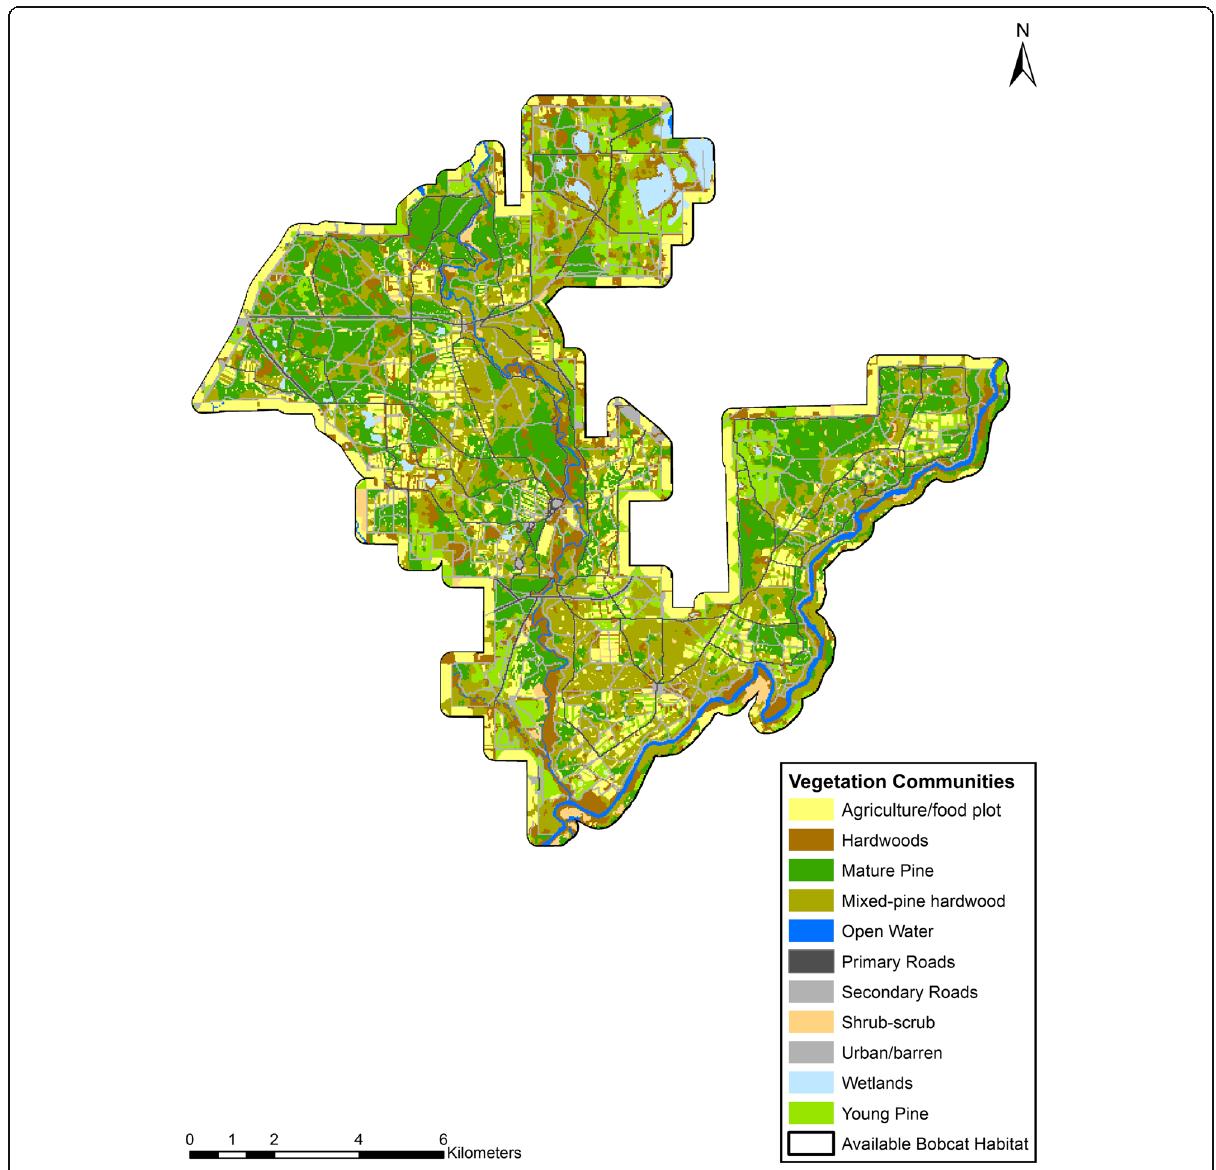
Fig. 2 Vegetation communities located at the Joseph W. Jones Ecological Research Center at Ichauway located in southwestern Georgia,